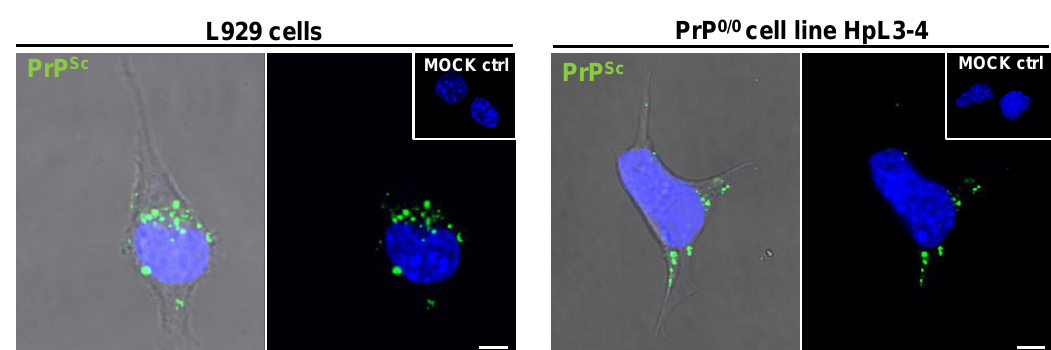
observed in both fibroblast cells and PrP-deficient cells. Monoclonal anti-PrP antibody: 4H11. Nuclei were counterstained with Hoechst (blue). Scale bar: 5